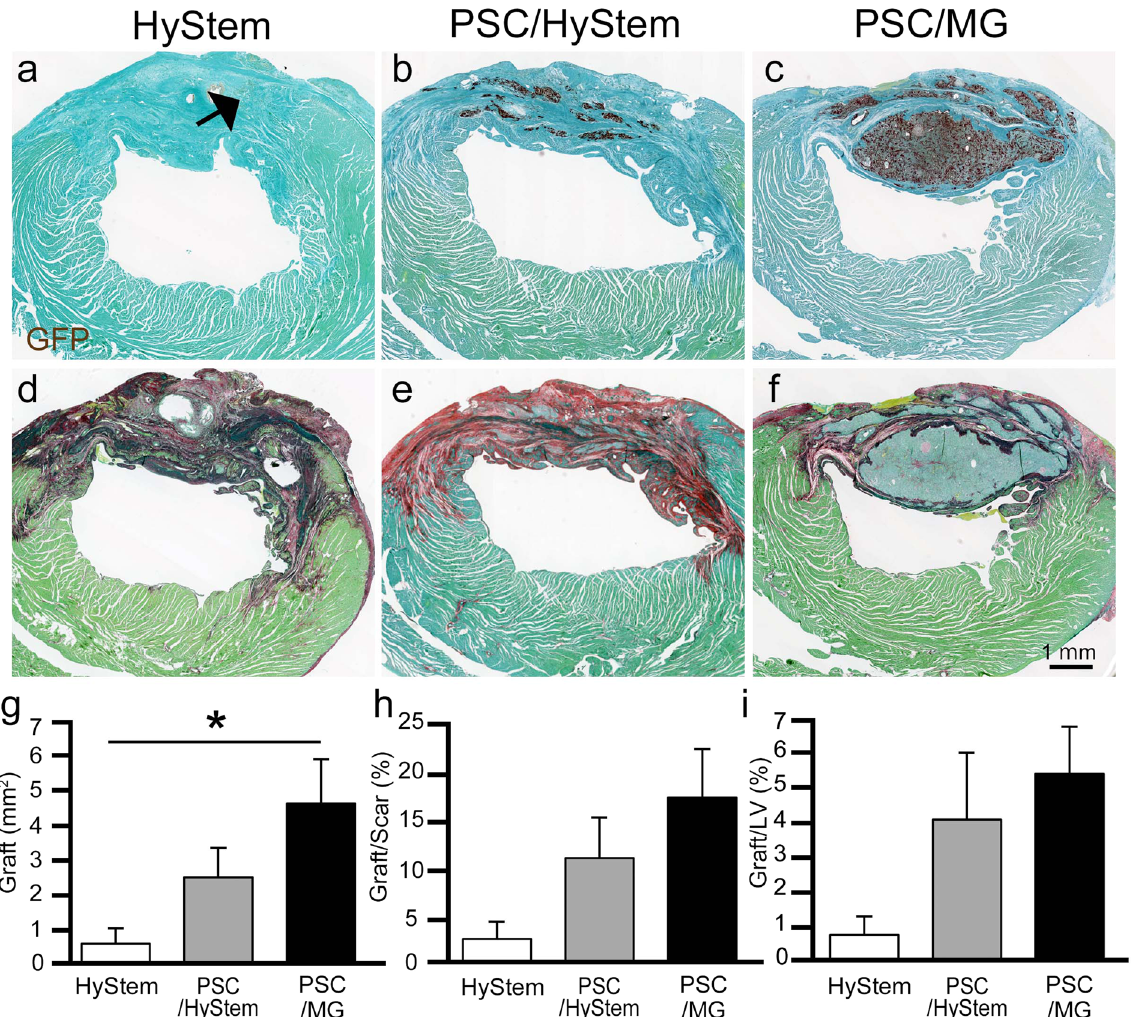
Figure 1. Partial remuscularization of the infarcted myocardium using human iPS cell-derived cardiomyocytes is shown. A week after myocardial infarction induction, human iPS cell-derived cardiomyocytes, diluted with HyStem (n = 5), PSC/HyStem (n = 5), or PSC/MG (n = 7), were transplanted directly into the infarcted myocardium. The heart was excised for histological analysis at 4 weeks post transplantation. ( a – c ) Immunostaining against the graft marker with GFP (brown DAB deposit), counterstained with fast green. While only a small portion of grafted tissue (arrow) was observed in the HyStem group, a substantial amount of grafted tissue was observed in the PSC/HyStem and PSC/MG groups. ( d – f ) Picro-sirius red staining of sections in close proximity to ( a – c ) show that most of the grafted tissue was located in the infarcted scar tissue. ( g ) Graft area, * P < 0.05. ( h ) Graft area relative to scar area. ( i ) Graft area relative to the left ventricular area. PSC, pro- survival cocktail; MG, Matrigel; GFP, green fluorescent protein; DAB,